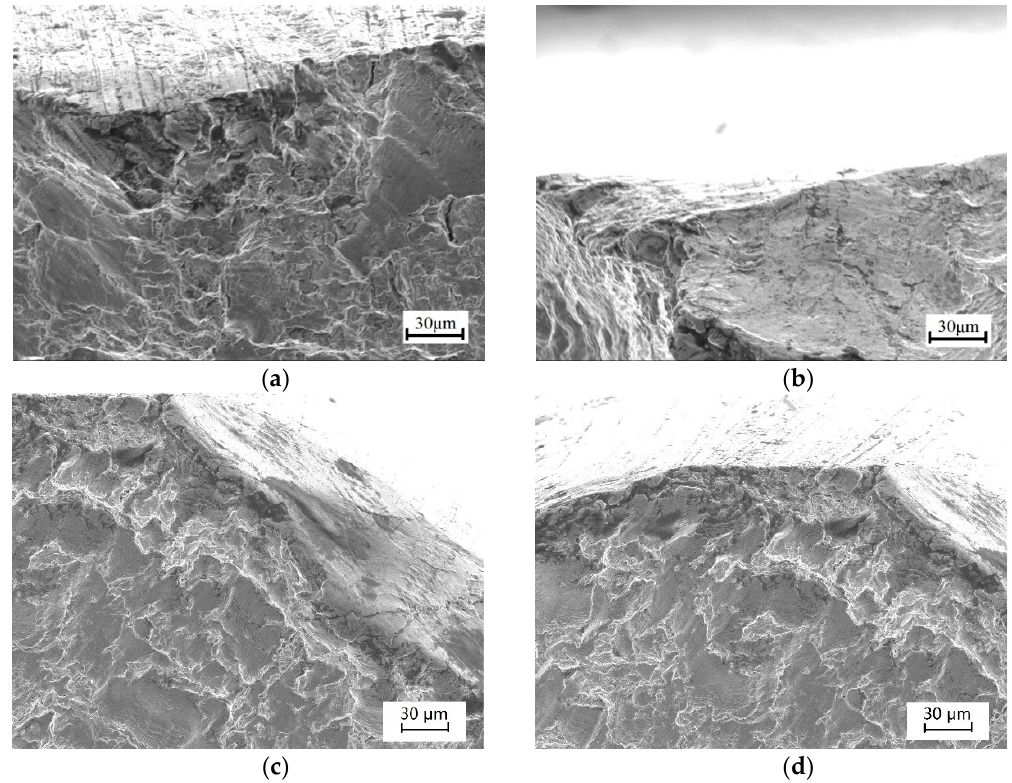
Figure 10. Surface crack ridges of the specimens taken by SEM: ( a ) ± 50 MPa loading level without EPT; ( b ) ± 50 MPa loading level with EPT; ( c ) ± 90 MPa loading level without EPT; ( d ) ± 90 MPa loading level with EPT.